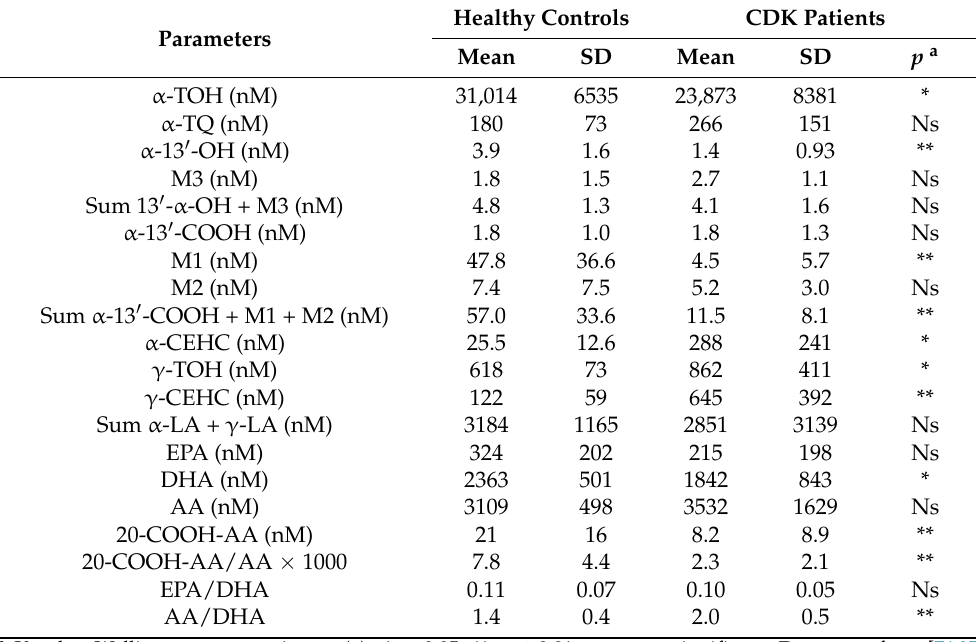
Table 2. Vitamin E and PUFA parameters in plasma of healthy control subjects and chronic kidney disease (CDK) patients measured by the developed LC-MS/MS method (23 observations). Healthy Controls CDK Patients Parameters Mean